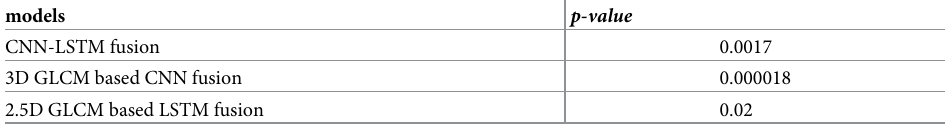
Table 6. The T-test p -values obtained comparing the average AUC of the LSTM-based deep fusion of 3D-GLCMs with other baseline